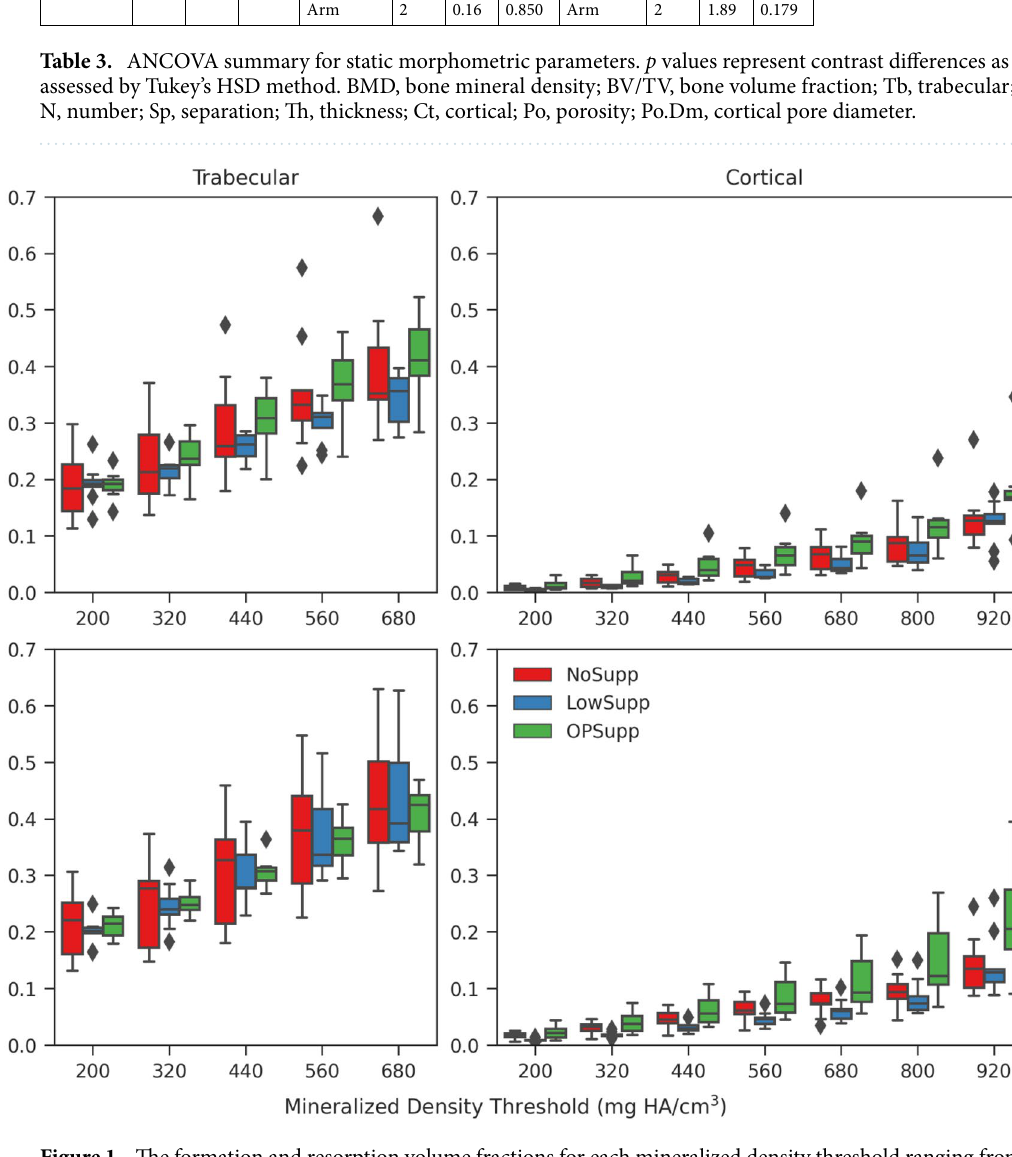
Figure 1. The formation and resorption volume fractions for each mineralized density threshold ranging from 200 mg Hydroxyapatite (HA)/cm 3 to 680 mg HA/cm 3 for trabecular bone and 920 mg HA/cm 3 for cortical bone with 120 mg HA/cm 3